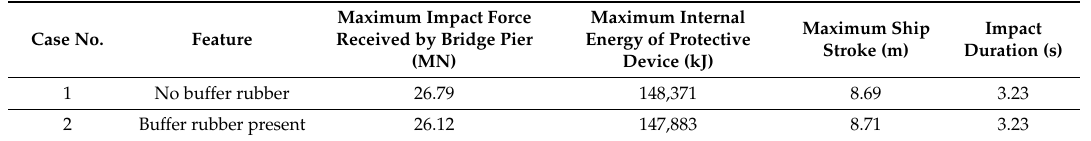
Table 10. Simulation results of bridge pier with and without buffer rubber equipment.